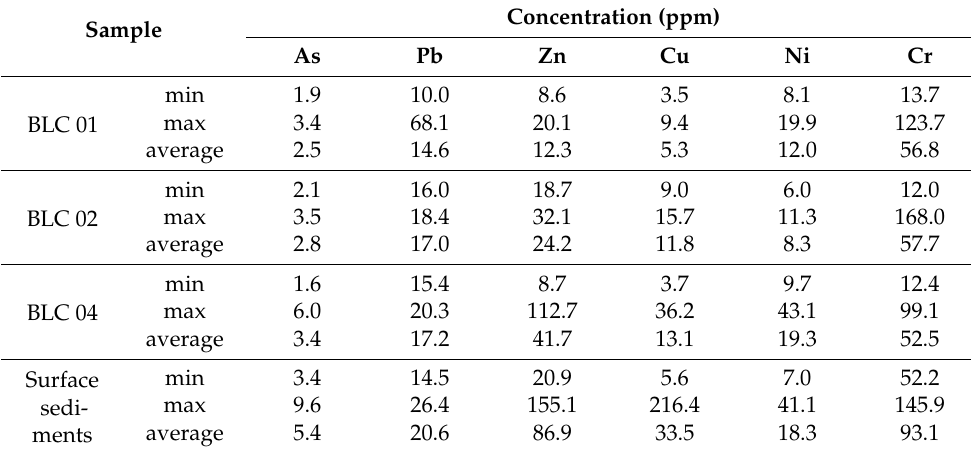
Figure 5. Vertical profiles of trace element concentrations in Batticaloa lagoon cores. Marine and freshwater sediment quality guidelines (SQG) values are marked (TEC: Threshold Effect Concentration, PEC: Probable Effect Concentrations, IAEA: International Atomic Energy Agency). Table 1. Statistical summary of trace element concentrations in sediment cores and surface sediments, Batticaloa lagoon, Sri Lanka.